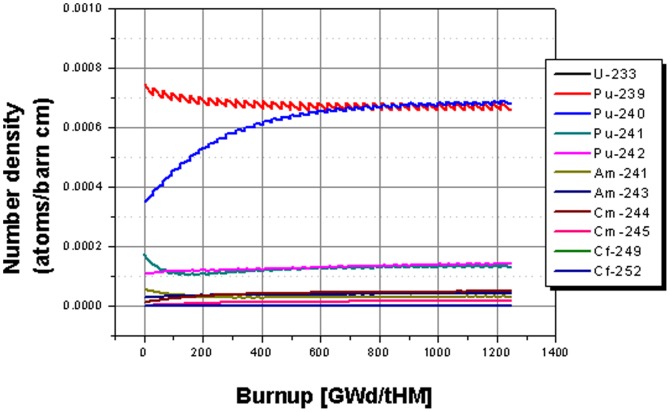
Evolution of the isotope inventory for the case based on U-238 fertile material.